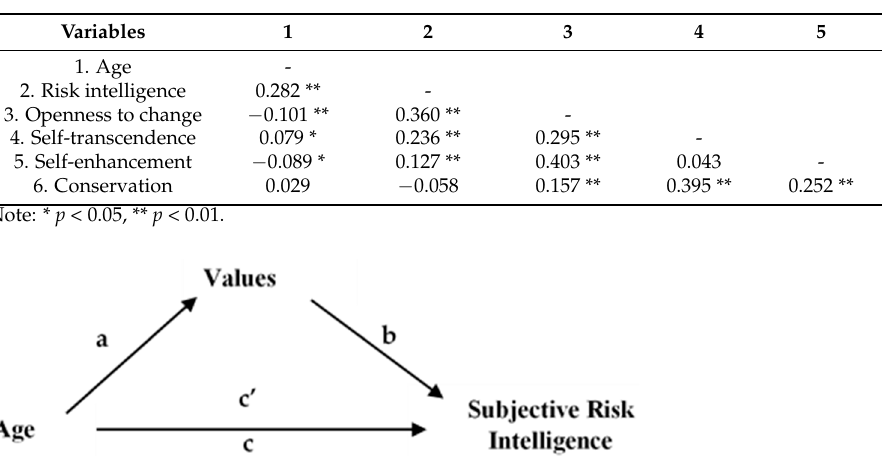
Table 2. Bivariate correlations between model variables (Spearman’s rho).